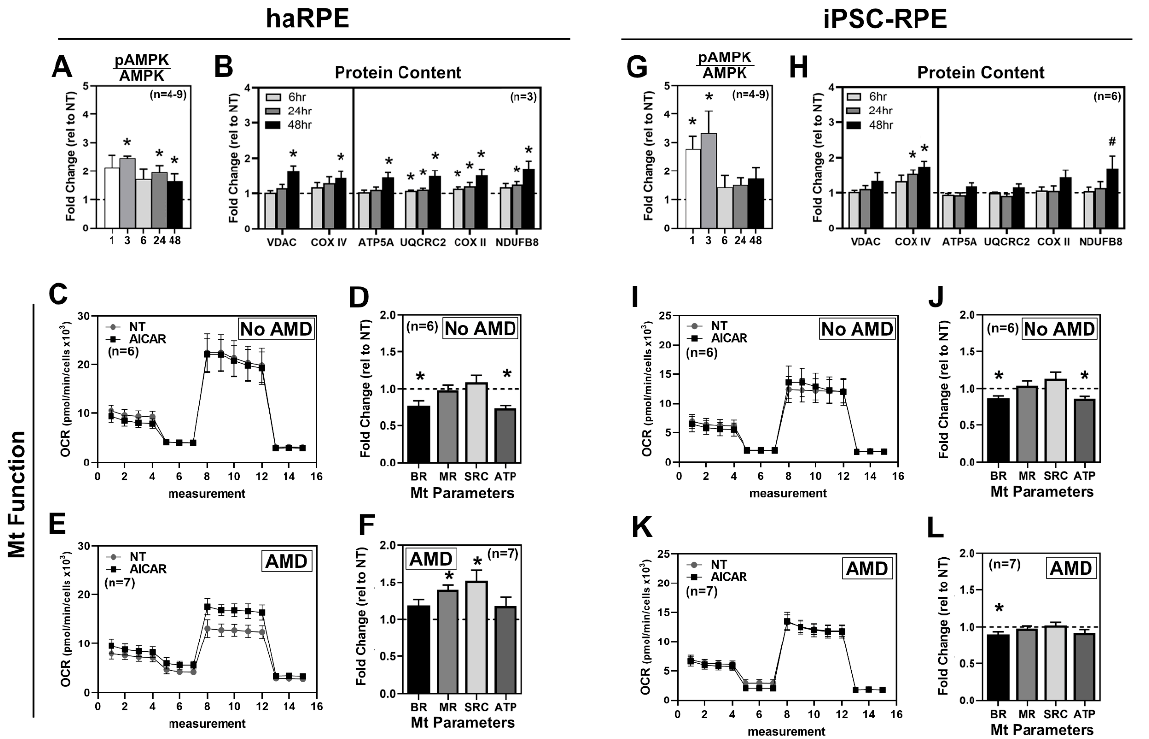
Figure 3. Response to AICAR. haRPE ( A – F ) or iPSC-RPE ( G – L ) were treated with 500 µ M AICAR, then assayed at the indicated time. ( A , G ) pAMPK to AMPK ratio from Western immunoblots. ( B , H ) Quantification of mitochondrial proteins. ( C , I ) OCR trace from No AMD donors for no treatment (NT) or after treatment. ( D , J ) Mitochondrial (Mt) functional parameters from No AMD donors. ( E , K ) OCR trace from AMD donors for no treatment (NT) or after treatment. ( F , L ) Mitochondrial functional parameters from AMD donors. Sample size is indicated in each panel. * denotes p < 0.05.